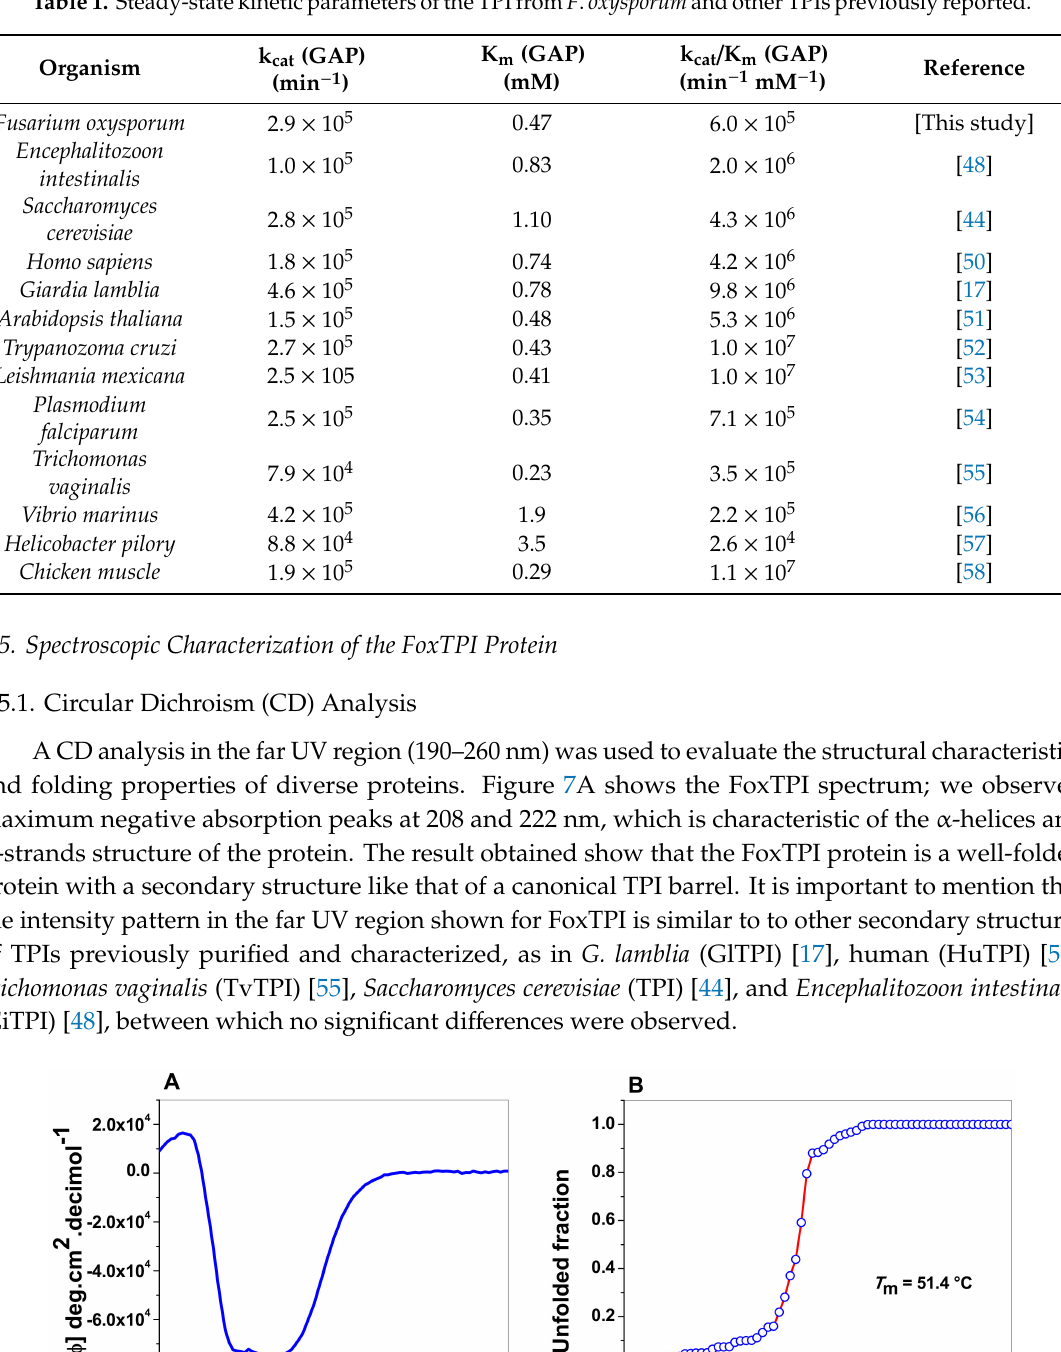
Table 1. Steady-state kinetic parameters of the TPI from F . oxysporum and other TPIs previously reported.